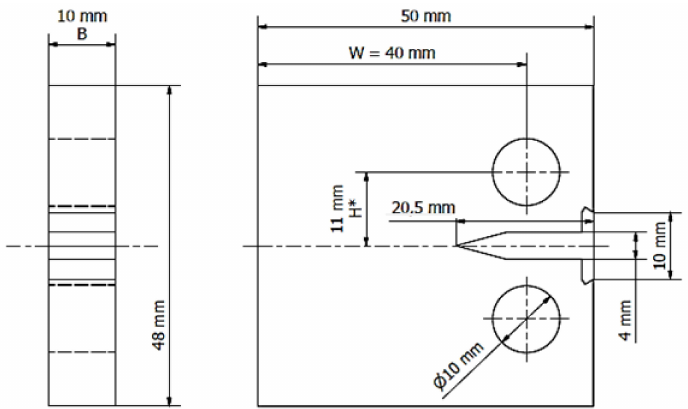
Figure 5. Basic dimensions of CT specimen used for determination of mechanical characteristics describing fracture toughness of Al–Ti layered material and its base materials.